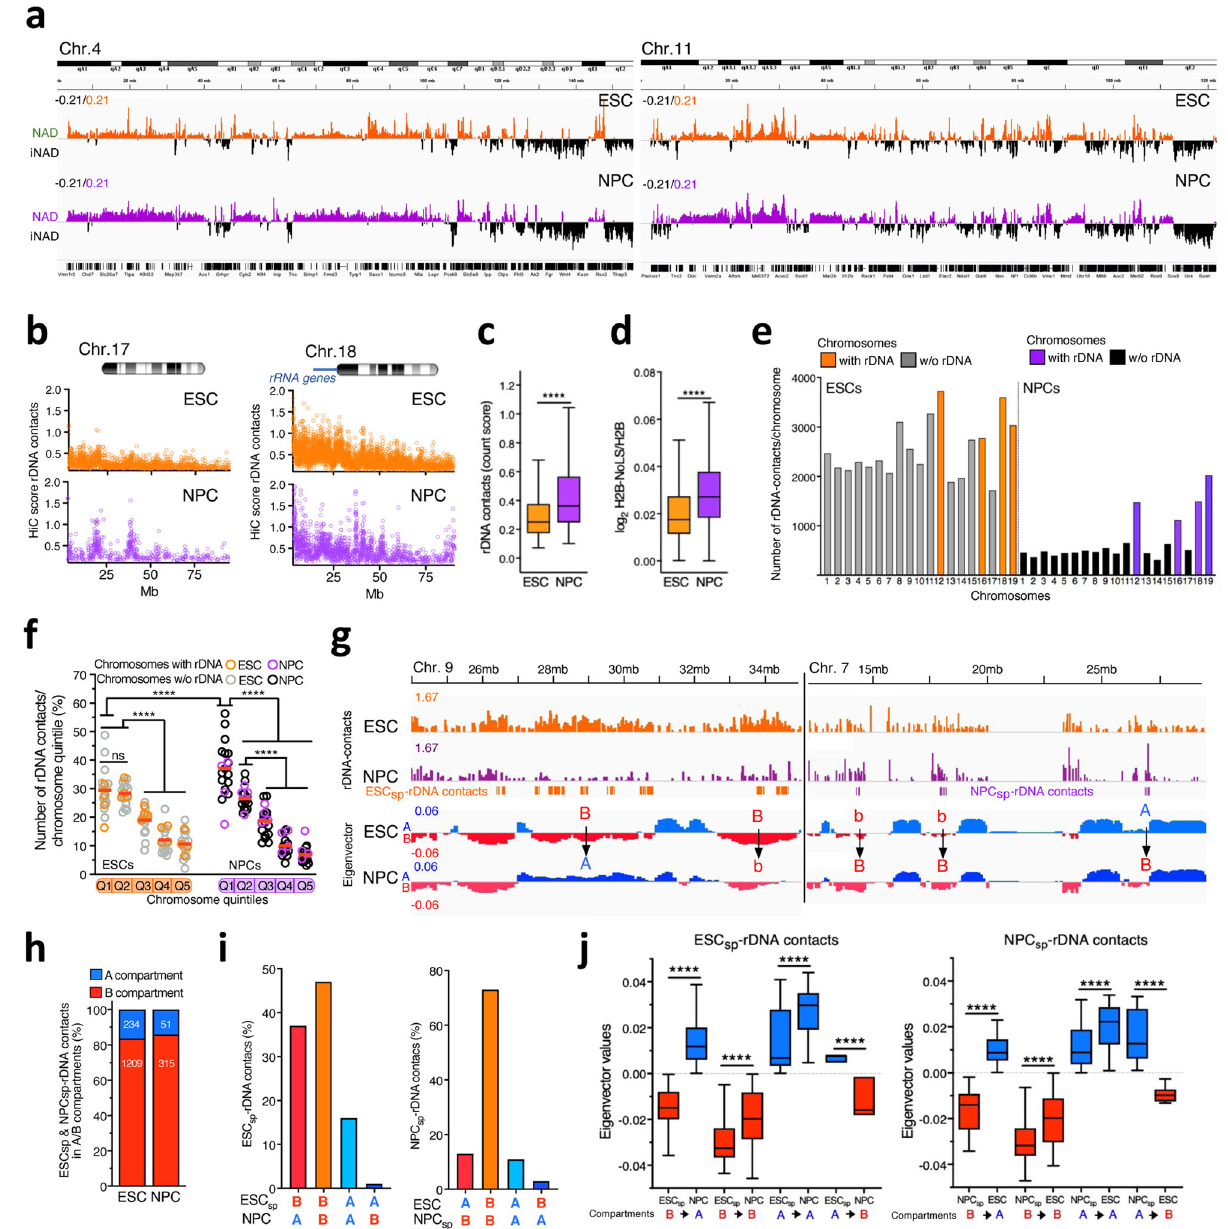
Fig. 5 ESC and NPC differ in their chromosome organization around the nucleolus. a Nucleolar-DamID. Chromosomal view of NADs in ESCs and NPCs. NADs are measured as log 2 ratio of m6A levels between H2B-Dam-NoLS and H2B-Dam. iNAD: regions not contacting the nucleolus. iLAD: regions not contacting the NL. Chromosomes 4 and 11 are shown. b Representative images showing HiC-score of rDNA contacts at chromosome 18, which contains rRNA genes and chromosome 7. c , d Genomic contacts with the nucleolus are more frequent in NPCs than in ESCs. HiC-score of rDNA contacts ( c ) and Nucleolar-DamID values of NADs ( d ) in ESCs and NPCs. Statistical signi fi cance ( P -values) was calculated using the unpaired two-tailed t test (****<0.0001). Box plots depict the minimum and maximum values. The horizontal line within the boxes represents the mean value. e ESCs have more rDNA contacts than NPC. Number of unique rDNA contacts at chromosomes in ESCs and NPCs. f rDNA contacts are enriched in the centromeric-proximal regions of chromosomes of NPCs relative to ESCs. To allow a better comparison, data of ESCs of Fig. 2f were plotted together with data of NPCs. Values represent the proportion of rDNA-contacts for each chromosome quintile. Statistical signi fi cance ( P -values) was calculated using the unpaired two-tailed t test (****<0.0001). g Representative images of ESC sp - and NPC sp -rDNA contacts and their eigenvector values for A and B compartment. B to A and A to B represent switch of compartments. B to b and b to B indicate a decrease or increase of eigenvector values between ESCs and NPCs. h ESC sp - and NPC sp - rDNA contacts are in the repressive B compartment. Amounts (%) of ESC sp - and NPC sp -rDNA contacts in A and B compartments. i Values represent the number of ESC sp - and NPC sp -rDNA contacts and their corresponding location in A and B compartments of ESCs and NPCs. j Box plots showing eigenvector values of ESC sp - and NPC sp -rDNA contacts in the active A and repressive B compartments. Statistical signi fi cance ( P -values) was calculated using the paired two-tailed t test (****<0.0001). Box plots depict the minimum and maximum values. The horizontal line within the boxes represents the mean value. Source data are provided as a Source Data fi